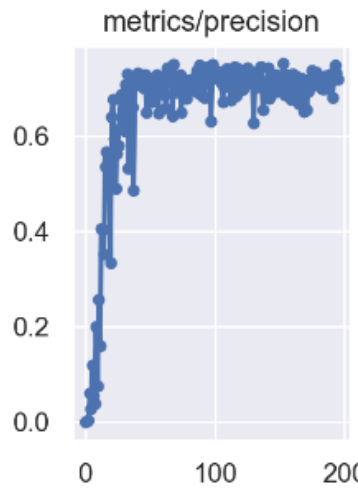
Figure A4. The changes of recall of YOLOV5s.